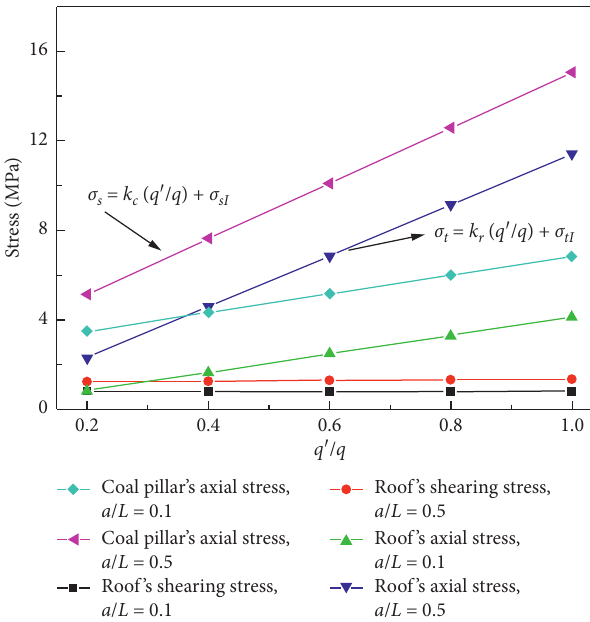
Figure 11: The relationship of the stress ratio q ′ / q .